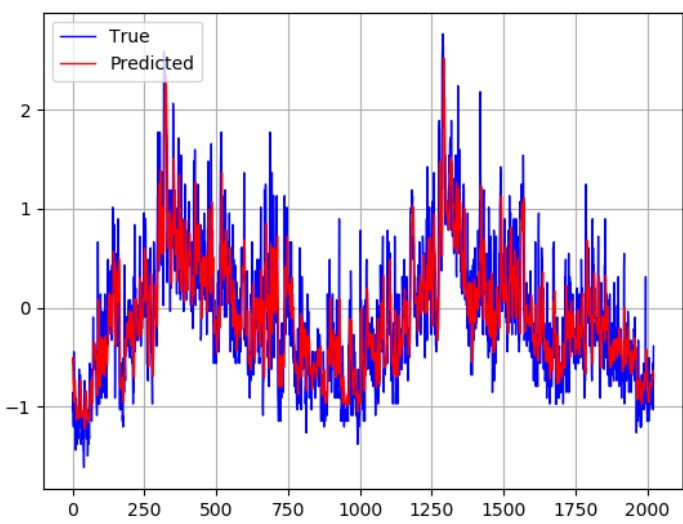
Figure 6. Example of the ARP algorithm result